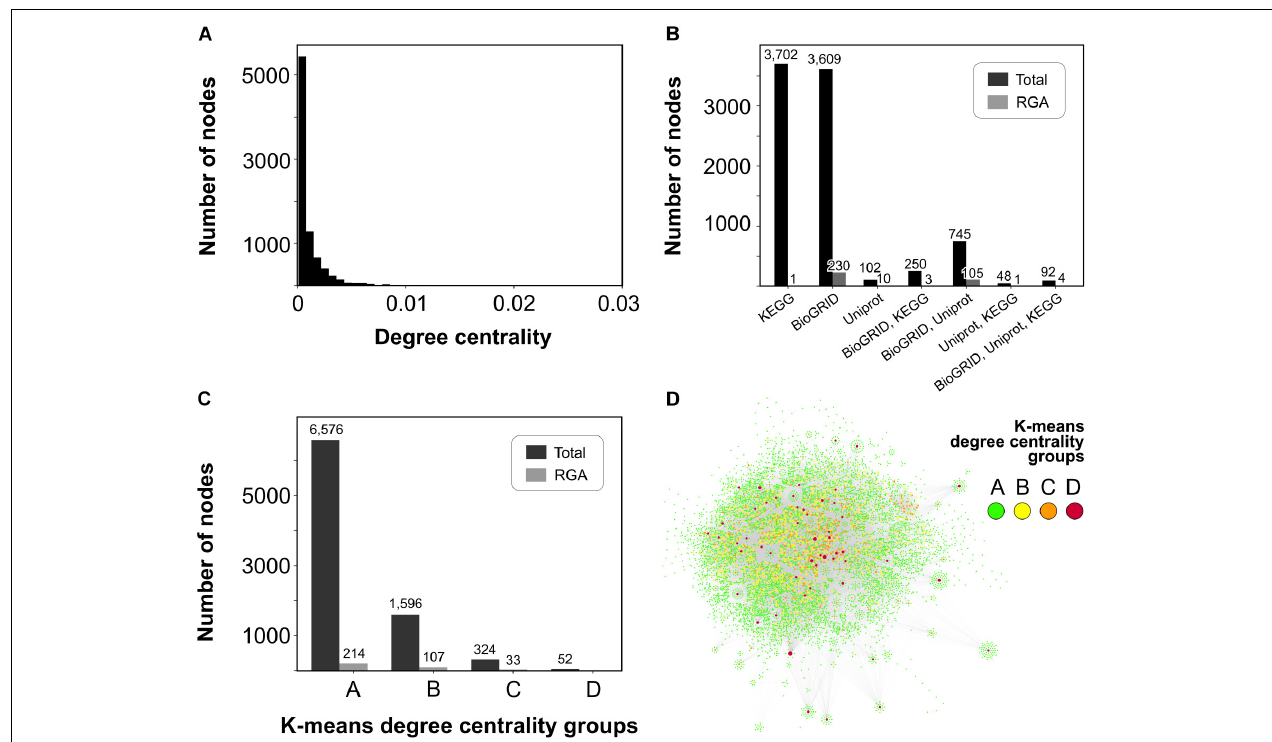
FIGURE 1 | Overview of the sugarcane dual-layered network topology. (A) Histogram of degree centrality showing the majority of nodes with low values. (B) The number of nodes from each of the three interaction databases is used in this work. (C) The number of total nodes and nodes harboring RGA orthologs in each of the four K -means degree centrality groups of (A) less connected, (B) intermediate connected, (C) highly connected, and (D) super-connected nodes. (D) Graph view of the largest component of the sugarcane dual-layered network with nodes colored according to the legend.